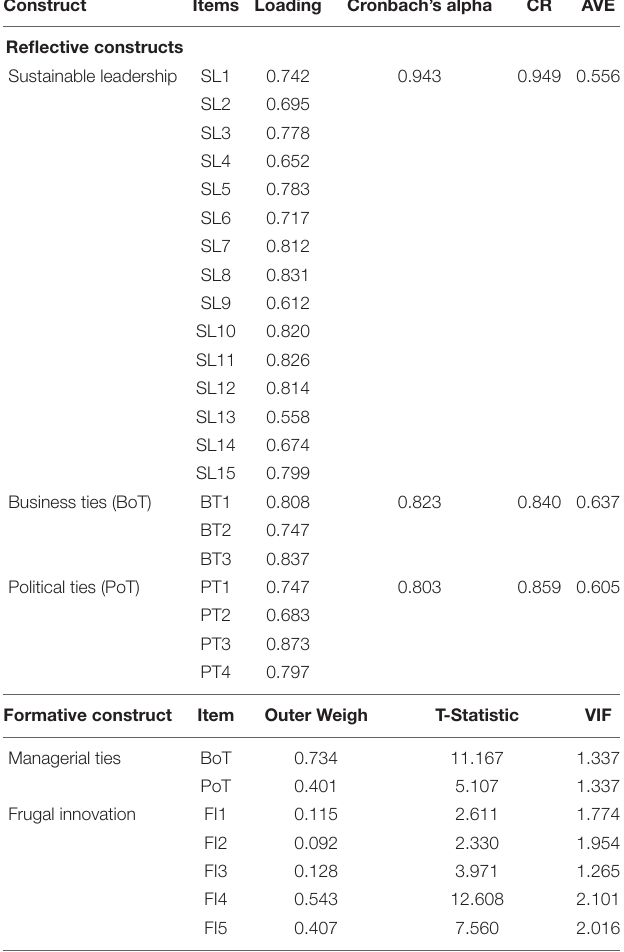
TABLE 2 | Reliability and validity of variables.